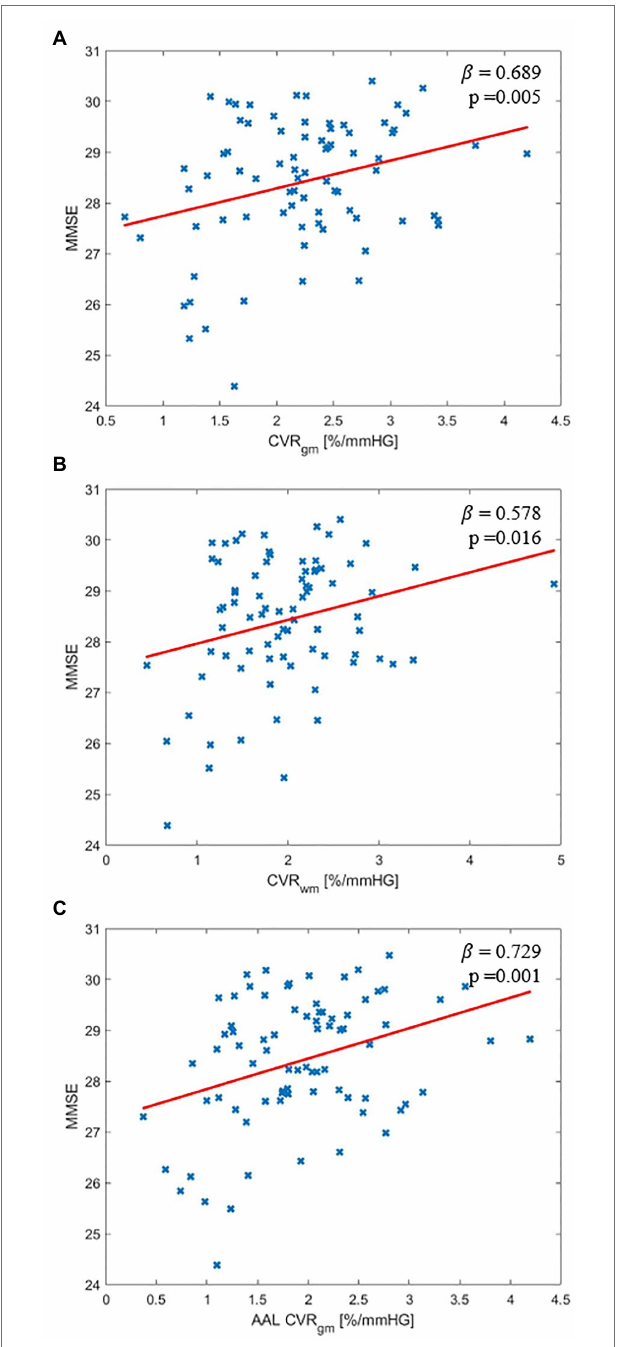
FIGURE 2 | Covariate adjusted relationship between Mini-mental state examination (MMSE) score and CVR: (A) Whole brain gray matter, (B) Whole brain white matter, and (C) Volume weighted average of reported 26 gray matter region of interests